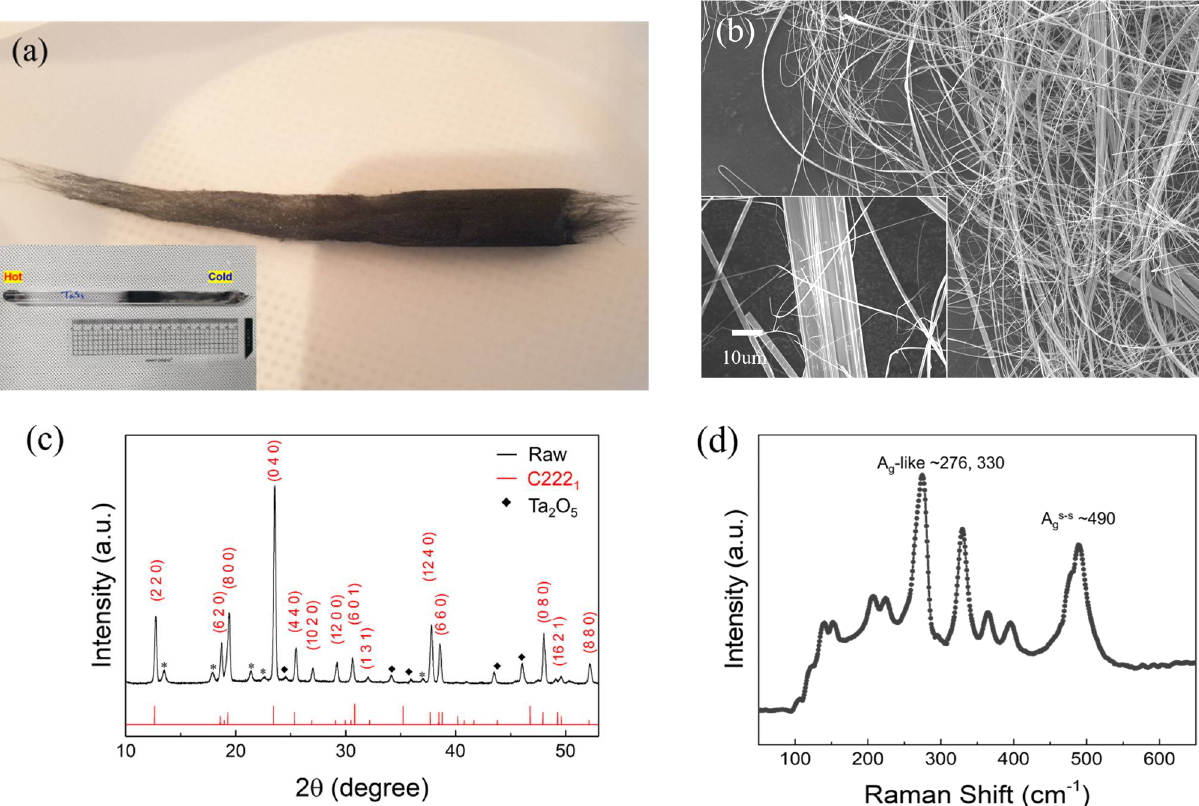
Figure 1. ( a ) Optical image of TaS 3 grown using chemical vapor transport (CVT); inset shows actual ampoule used for the synthesis of TaS 3 . ( b ) Secondary electron micrograph; inset shows zoom-in image of one of the TaS 3 bundles. ( c ) X-ray diffraction, and ( d ) Raman spectroscopy of TaS 3 .